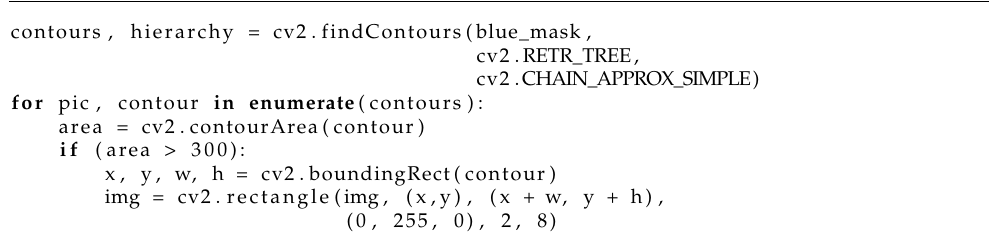
Algorithm 3 Colour detection algorithm in